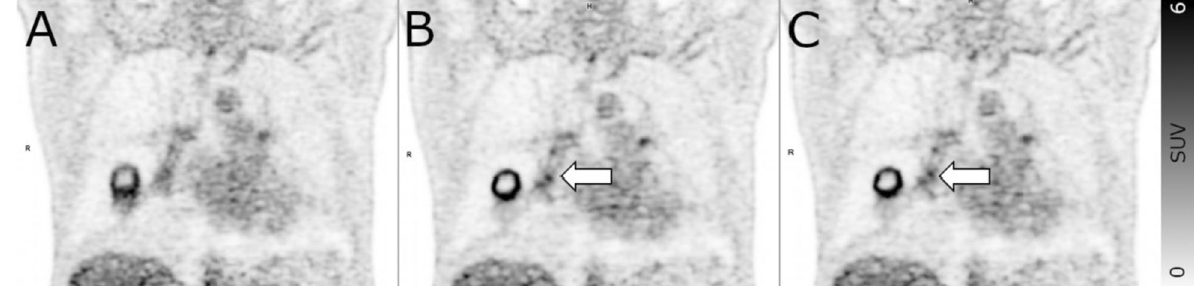
Fig. 3 Coronal PET images of a patient with non-small cell lung cancer in the right lung. Both readers rated N1 as free of metastases on static images ( A ). In contrast to the static images, areas of focal tracer accumulation are discernable in the right lung hilus on both BG-MC ( B ) and DDG-MC ( C ) images (arrows). Both readers rated N1 as metastatic on BG-MC and DDG-MC images. Transbronchial needle aspiration confirmed the presence of metastases in ipsilateral and contralateral mediastinal lymph nodes